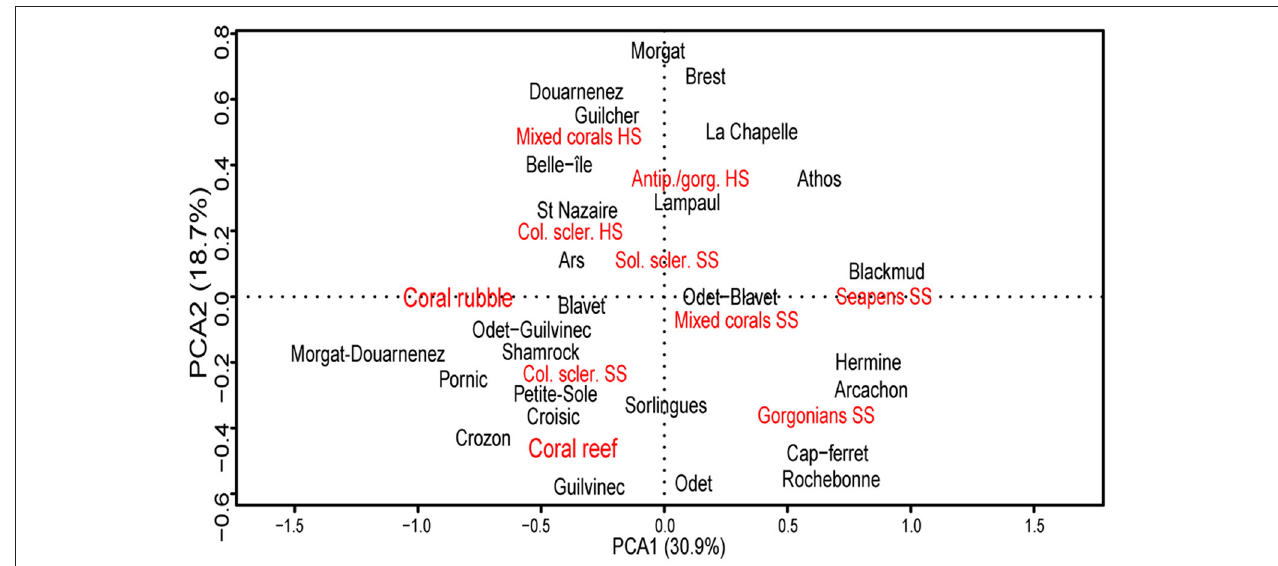
FIGURE 7 | Biplot ordination of canyons (in black) and coral habitats (in red) in the first two axis of a covariance PCA computed on the Hellinger-transformed linear of coral habitats per canyon. The Solitary scleractinians HS habitat was removed prior to analysis. Antip./gorg., Antipatharians/gorgonians; Col. scler., Colonial scleractinians; Sol. scler., Solitary scleractinians.